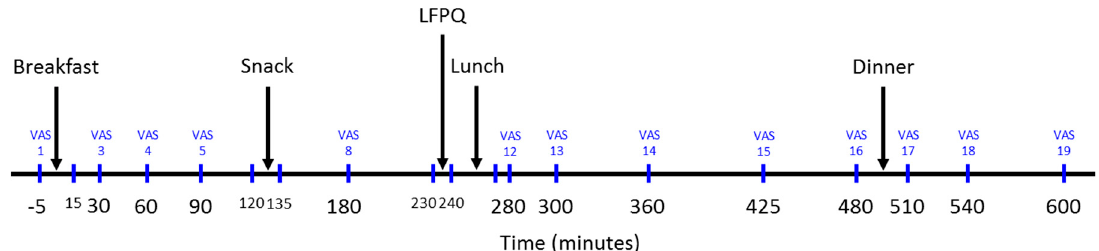
Figure 1. Schematic representation of the study procedure–experimental session. VAS–Visual Analogue Scale. LFPQ–Leeds Food Preference Questionnaire.